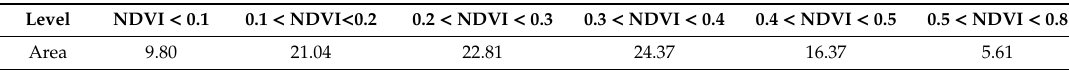
Figure 3. Vegetation spatial pattern, interannual variation trend and significance test. ( a ) NDVI_mean; ( b ) Sen’s trend / 10a; ( c ) Significance test (P < 0.05); ( d ) Significance test (P < 0.01); ( e ) Land use type; ( f ) Normalized Differential Vegetation Index (NDVI) and interannual rate of change. Table 1. Area statistics of NDVI values of each grade (Unit: